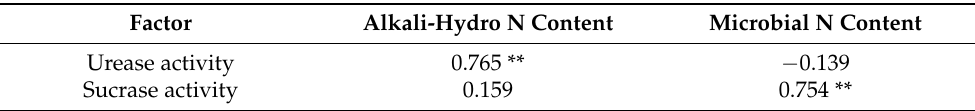
Table 7. The correlation coefficient between soil alkali-hydro N, microbial N content, and enzyme activity. Factor Alkali-Hydro N